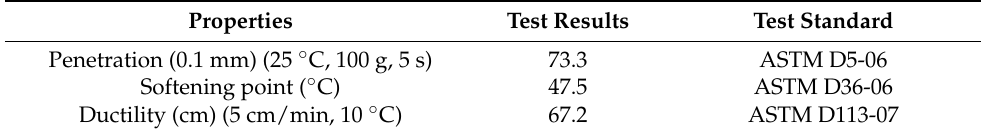
Table 1. Physical properties of PG64-16 matrix asphalt.